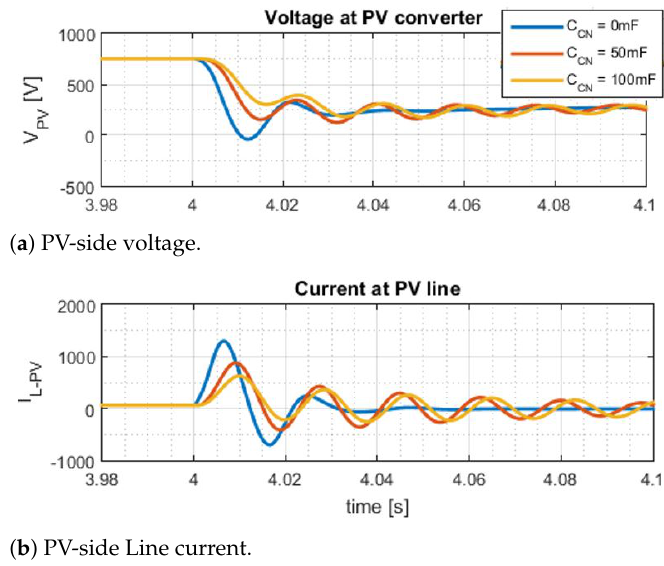
Figure 16. PV-Side response with EV-side fault.